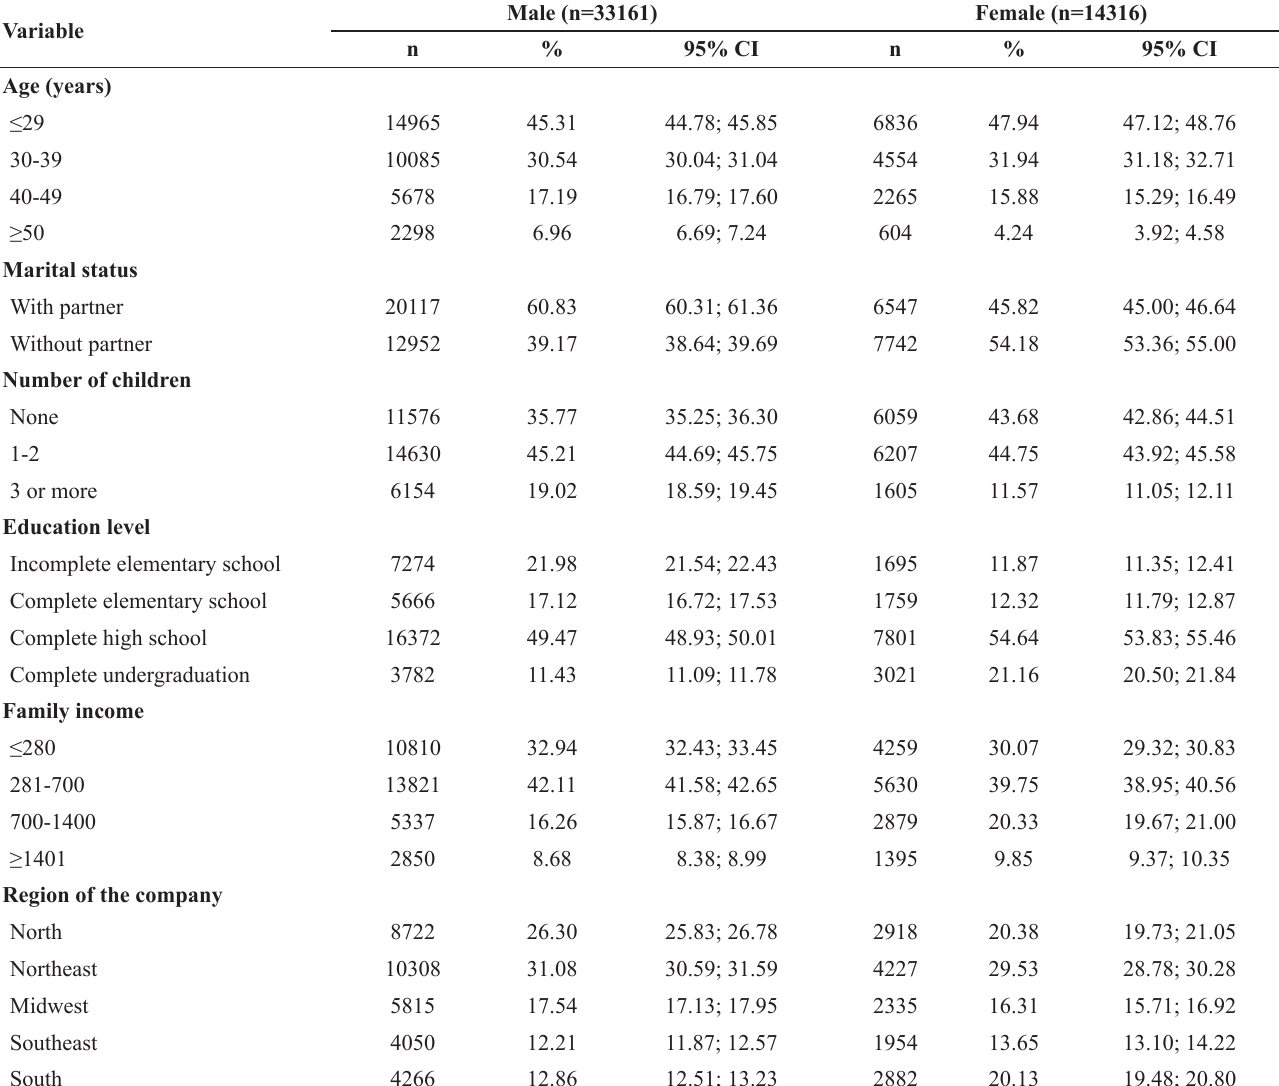
Table 1. Characteristics of industry workers Brazilian according to sex. Brazil, 2008.